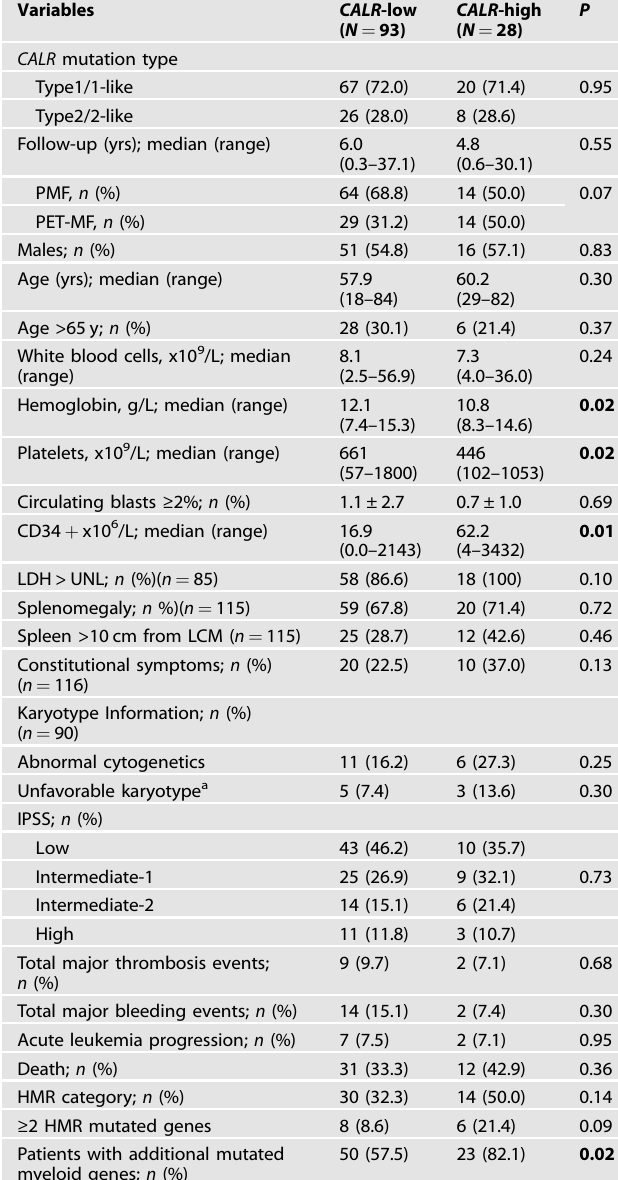
Table 1. Clinical and hematologic characteristics of 121 CALR -mutated patients with primary myelo fi brosis and post-essential thrombocythemia myelo fi brosis (PET-MF) divided according to their VAF ≥ 55% ( CALR -high) and <55% ( CALR